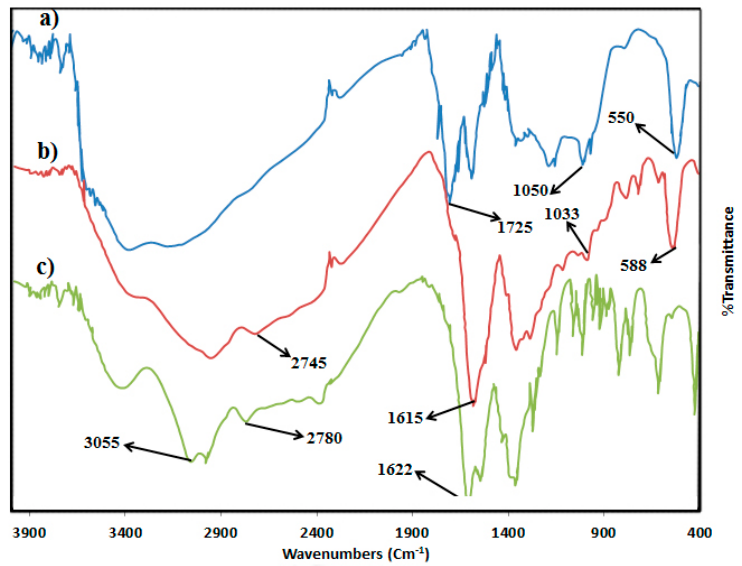
Figure 1. Fourier transform infrared (FT-IR) spectrum of GO ( a ), GO/Fe 3 O 4 / L -pro ( b ), and pristine L -proline ( c ).